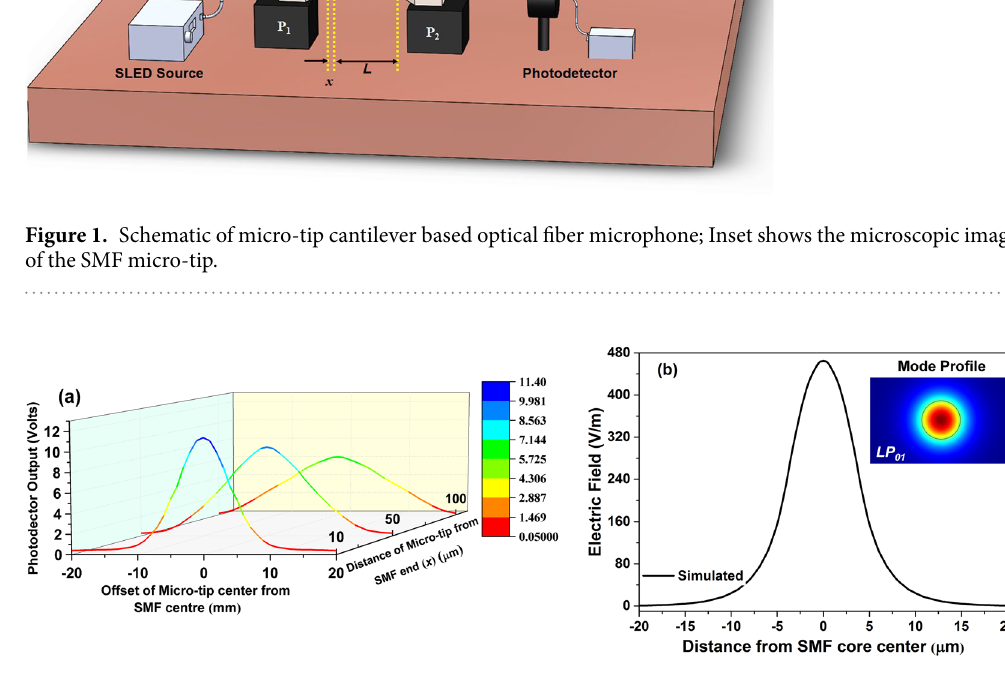
Figure 2. ( a ) The variation of micro-tip coupled light at different offset positions for different distance between micro-tip and SMF end; ( b ) simulated output electric field at SMF end with distance from the center of the SMF core; and inset of ( b ) shows the simulated mode profile of the standard